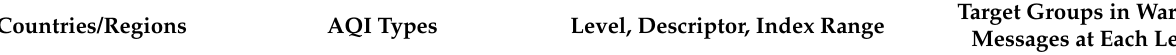
Table 1. Examples of the descriptors and target groups in warning messages of AQI from 11 countries/regions. Countries/Regions Level, Descriptor, Index Range